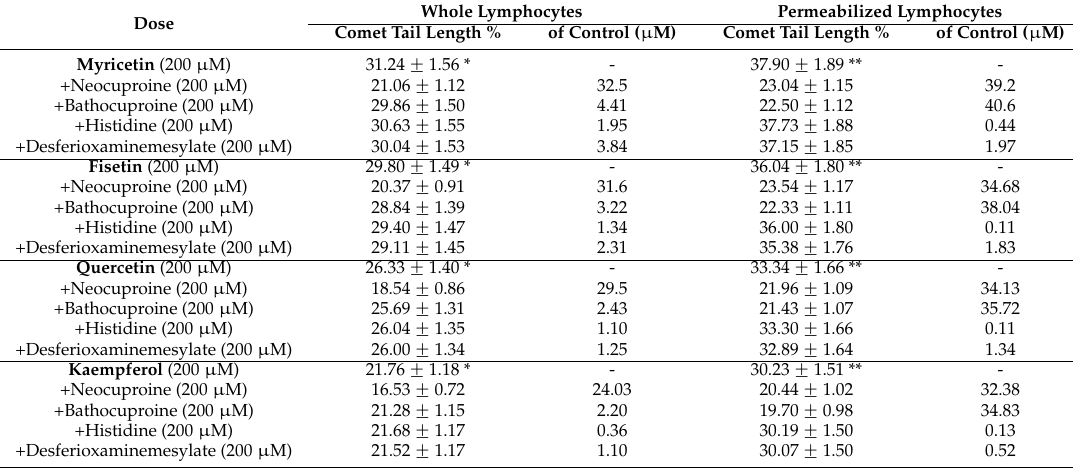
Table 3. Effect of chelators of metals on flavonoids-induced cellular DNA degradation in lymphocytes. Values shown in this table represent flavonoid-induced cellular DNA breakage in whole and permeabilized lymphocytes measured as a percentage of the control (DNA breakage in the absence of chelators). Data represent ±SEM of three independent experiments. * p < 0.05, compared to untreated whole lymphocytes (comet tail length = 3.43 ± 0.13). ** p < 0.05, compared to untreated permeabilized lymphocytes (comet tail length = 3.85 ± 0.17).